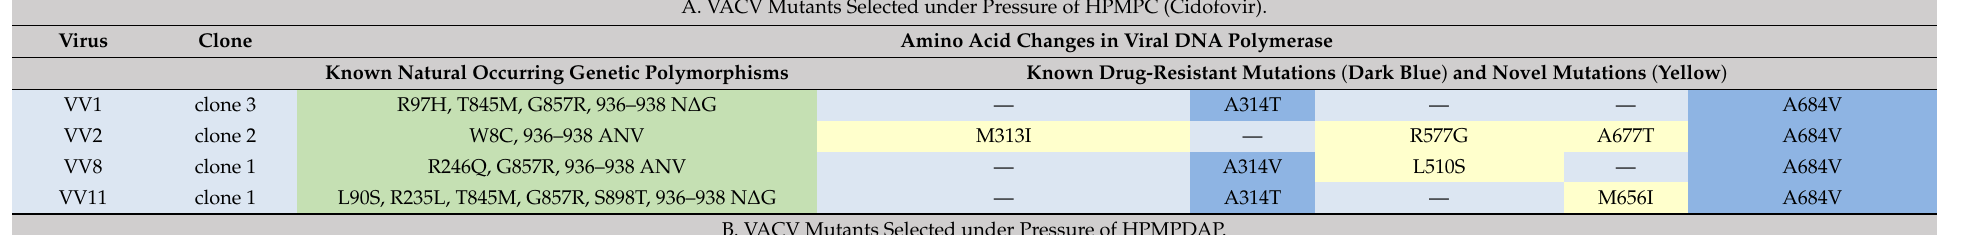
Table 3. Identification of amino acid changes in the VACV DNA polymerase following selective pressure with the ANPs HPMPC, HPMPDAP, and HPMPO-DAPy starting from four plaque-purified clones, denoted VV1, VV2, VV8, and VV11, isolated from the parental VACV Lederle strain. A. VACV Mutants Selected under Pressure of HPMPC